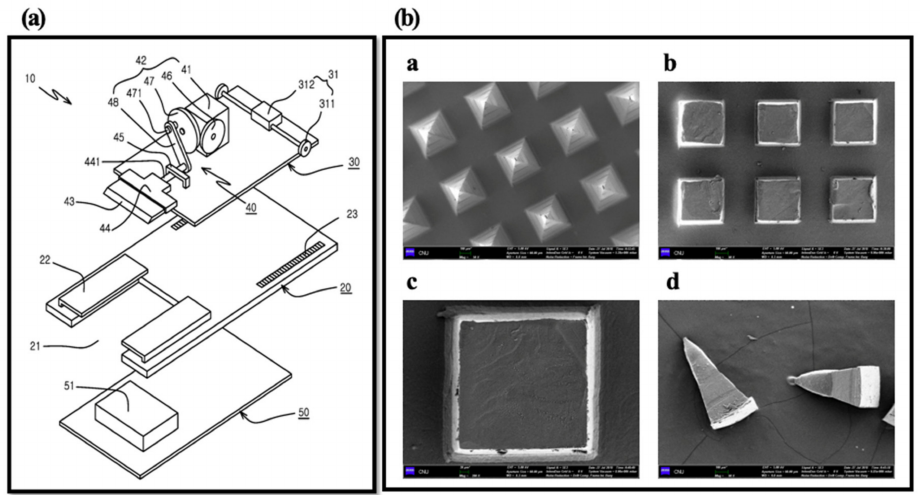
Figure 3. Diagram of lab made cutting device (Prof. Cho’s lab) ( a ) and SEM images of HBsAg MNs (( b )-a), MN section by cutting method (( b )-b and -c) and collected tip by cutter (( b )-d). Scale bar = 100 µ m ((b)a, b and d). Scale bar = 20 µ m